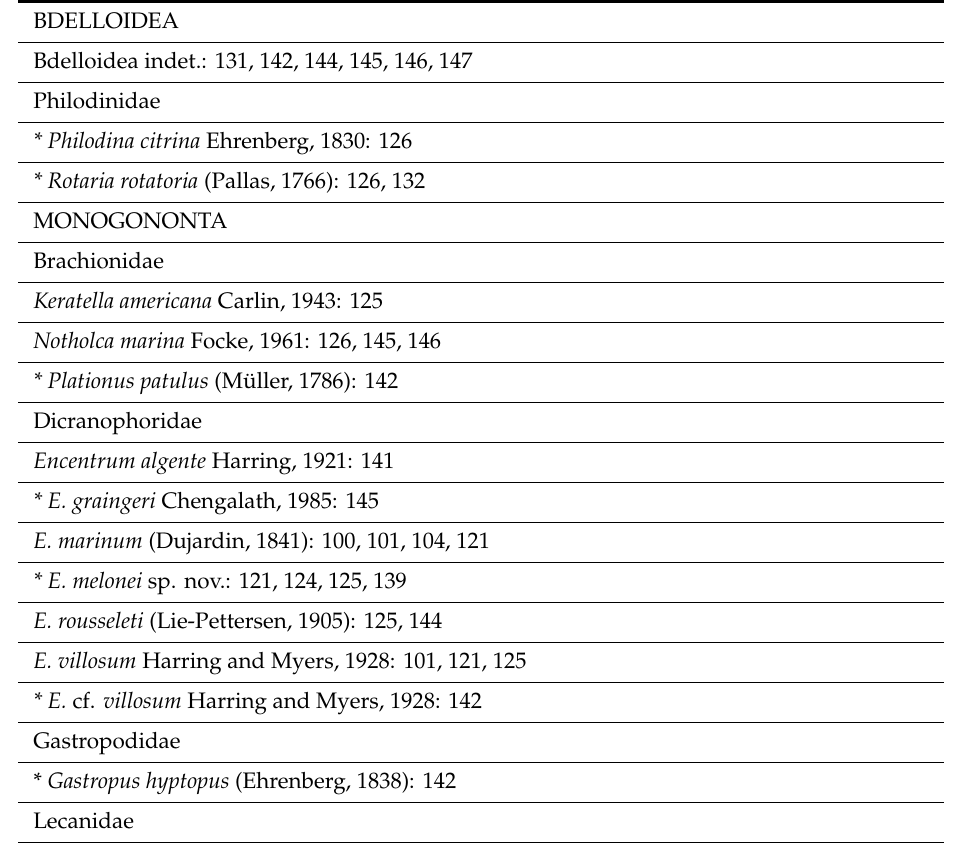
Table 2. Rotifer taxa collected at the di ff erent sampling sites 1 . Numbers refer to the sampling sites (Table